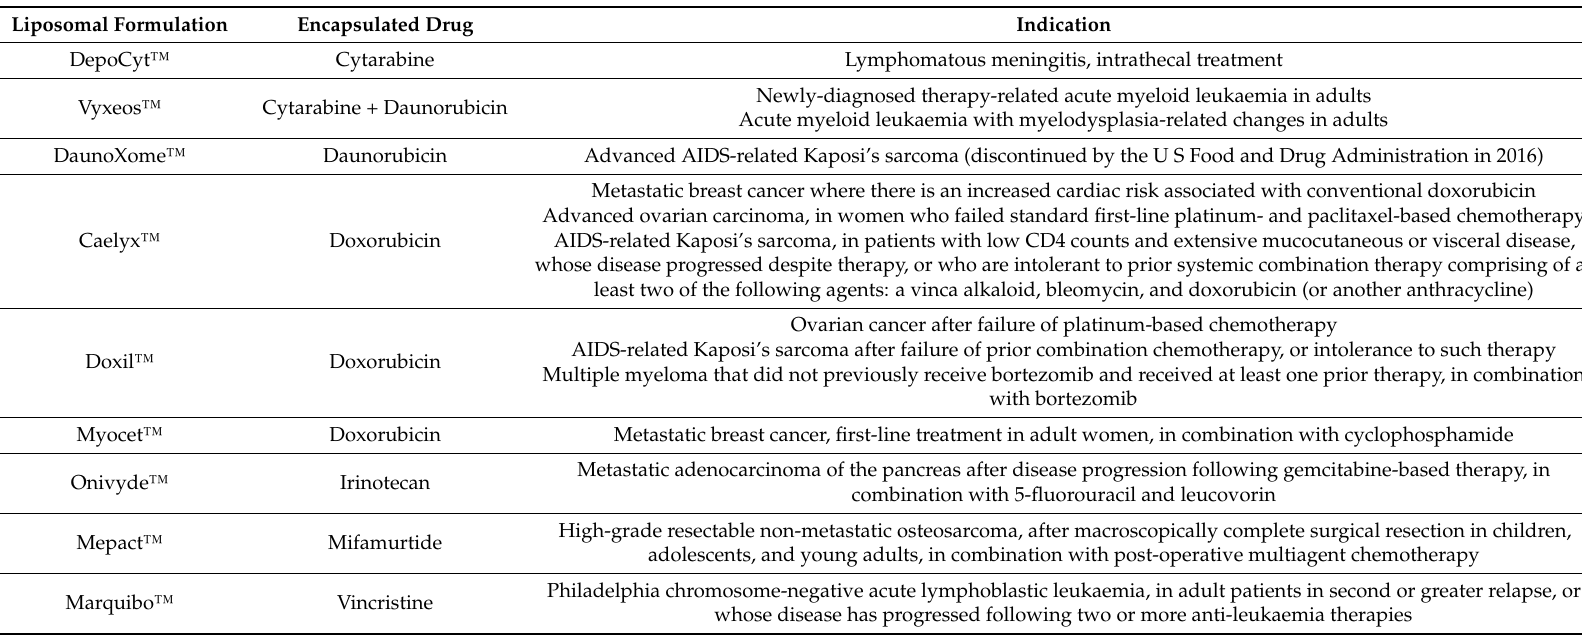
Table 2. Approved liposomal formulations for cancer treatment and their